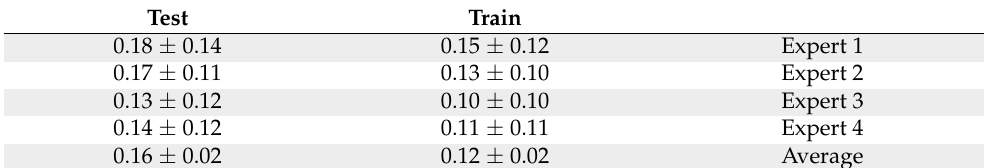
Table 9. Error in CDR estimation in OD segmentation and excavation (deviation ± mean) evaluated against different experts—adapted from [39].